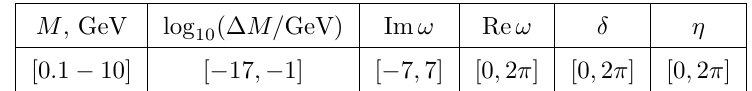
Table 1 . Parameters of the theory: common mass; mass di(cid:11)erence; Im ! ; Re ! ; Dirac and Majo- rana phases. In the second line we indicate the ranges of these parameters which were considered in this